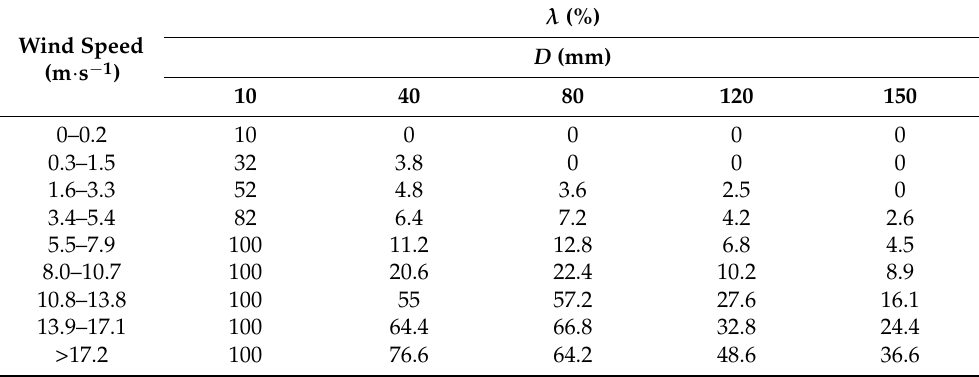
Table 7. Wet ratio of fence and floating balls at different wind